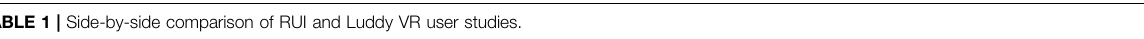
Luddy VR 2 (control, experiment) Volume, line, linguistic/text